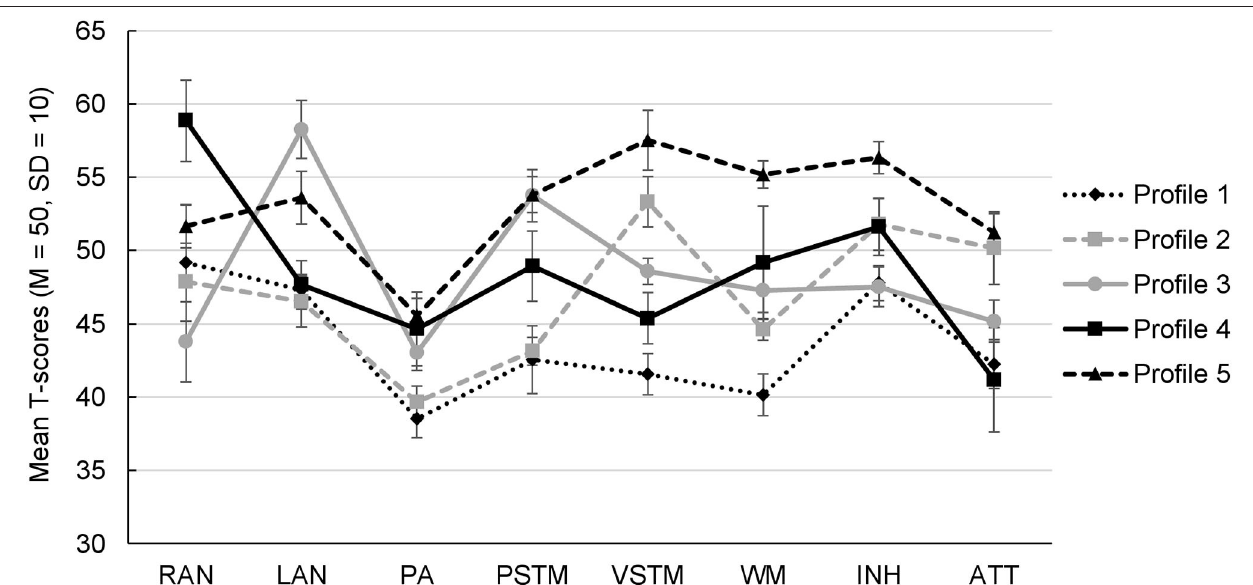
FIGURE 1 | Cognitive profile plot of the 5-profile solution. RAN, rapid automatized naming; LAN, semantic language skills; PA, phonological awareness; PSTM, phonological short-term memory; VSSP, visual-spatial short-term memory; WM, working memory; INH, inhibition; ATT, visual attention.